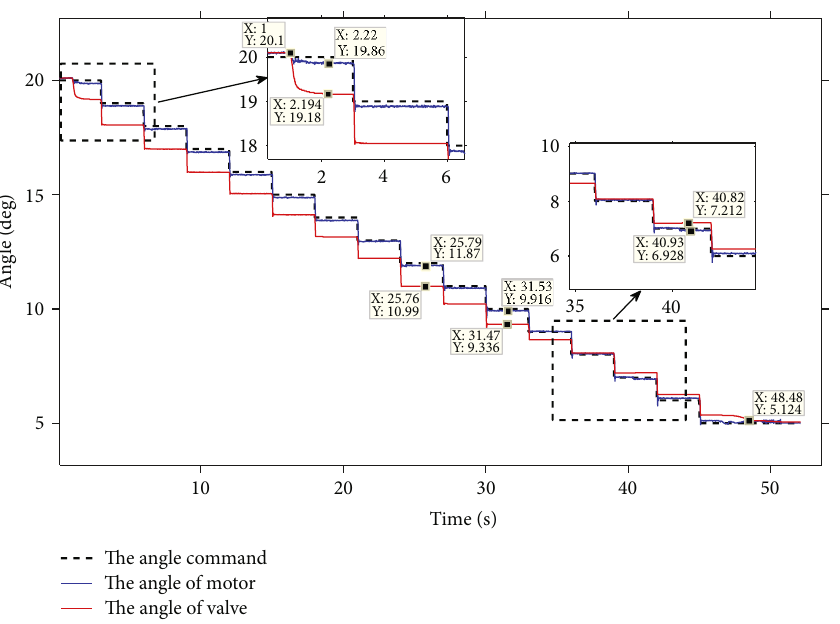
Figure 11: Valve angle response under large clearance conditions (second experiment).